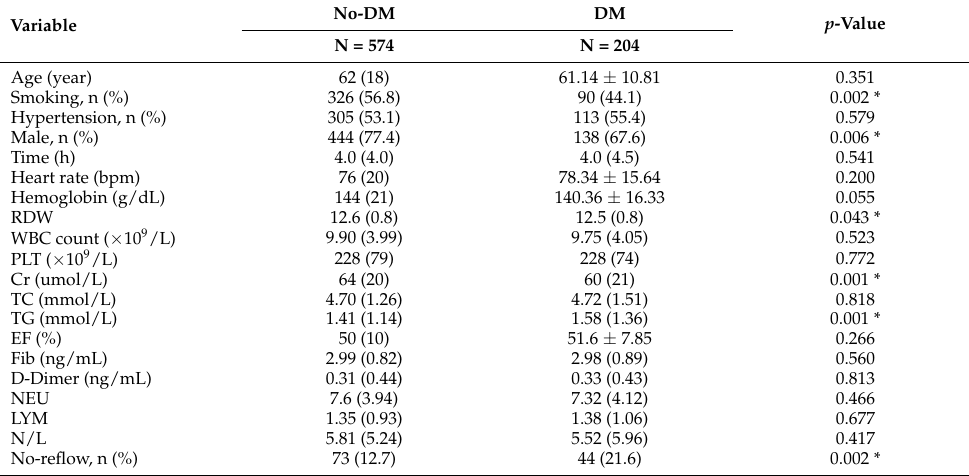
Table 2. Basic characteristics of patients with DM